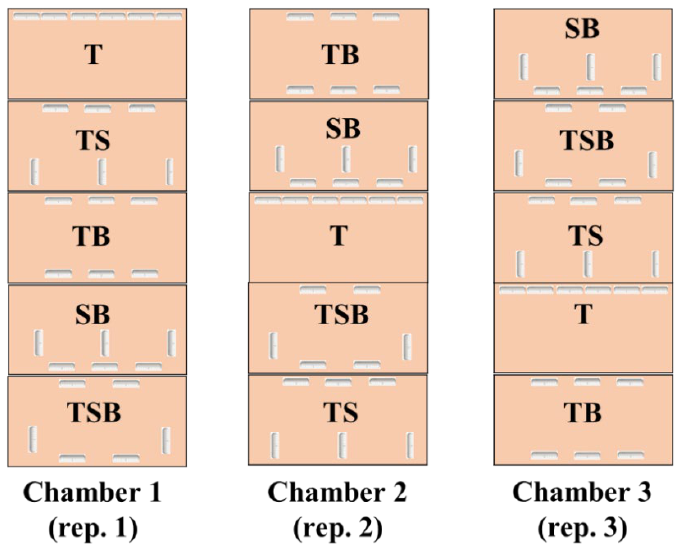
Figure 11. The experimental layout and design of the lighting direction combinations in plant growth chambers. T, TS, TB, SB, and TSB, refer to the top (1/1), top (1/2) + side (1/2), top (1/2) + bottom (1/2), side (1/2) + bottom (1/2), and top (1/3) + side (1/3) + bottom (1/3) lighting, respectively.